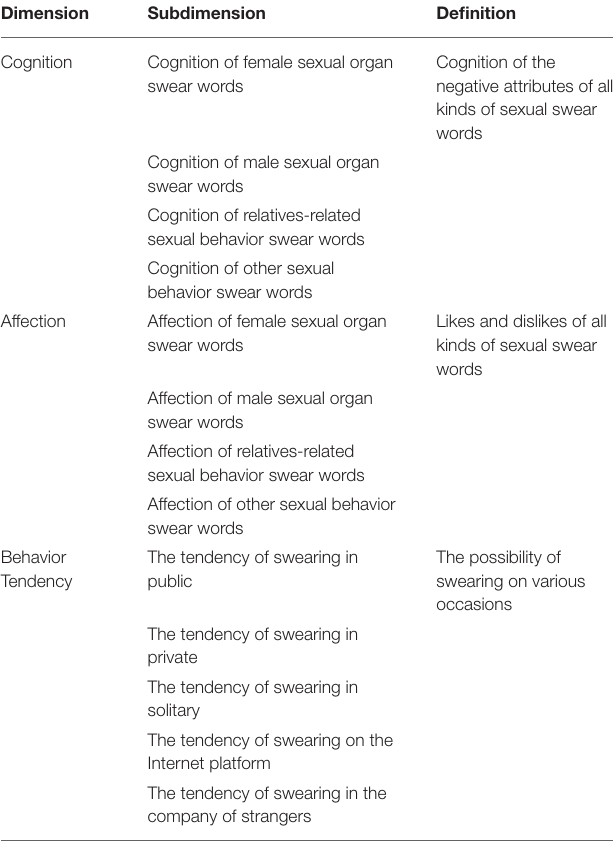
TABLE 1 | The dimensional structure of attitude of college students toward sexual swear words.